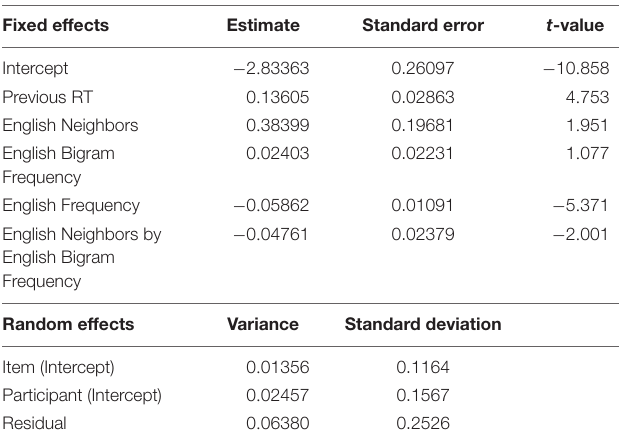
TABLE 5 | Final model for the non-word data in Experiment 1 (English Lexical Decision with